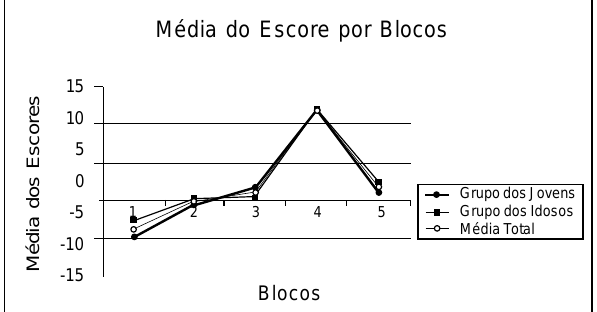
Figura 2 . Média dos escores por bloco, segundo critério vantajosos X desvantajosos, para a amostra total, o grupo de idosos e o grupo de